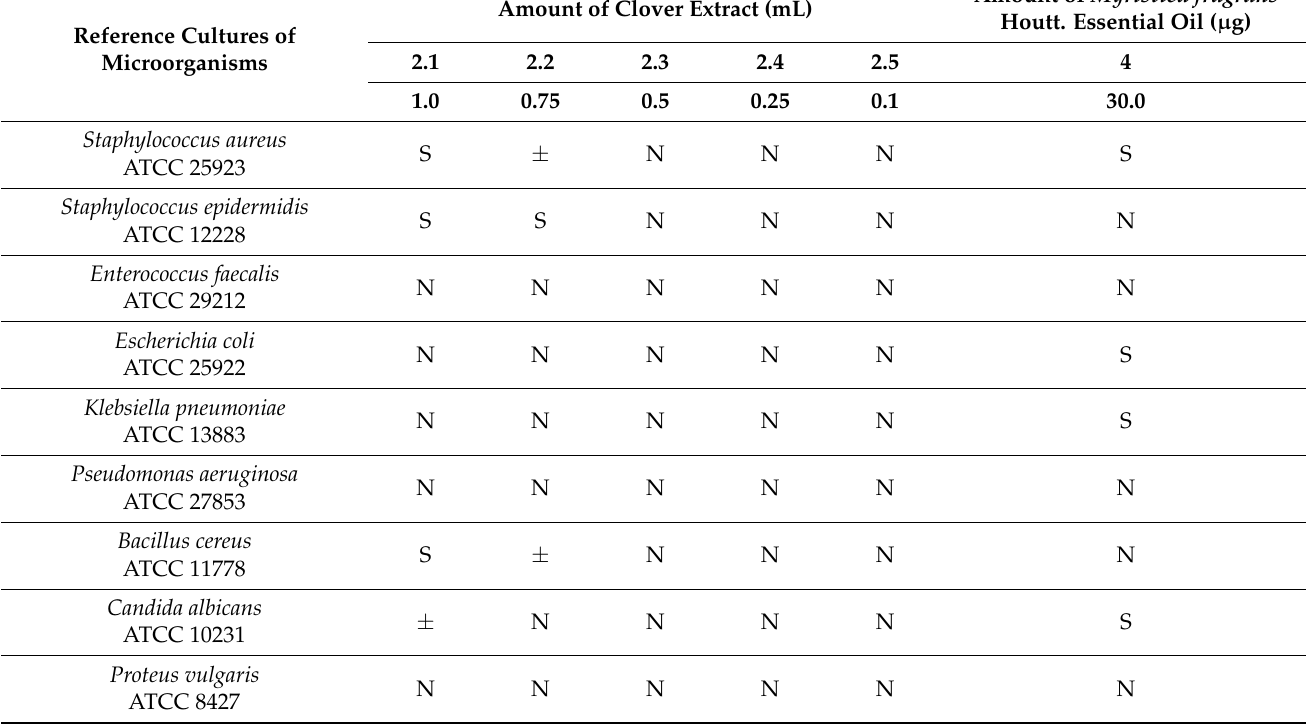
Table 4. Antimicrobial effect of Trifolium pratense L. extract and Myristica fragrans Houtt. Essential oil on the growth of reference microorganism